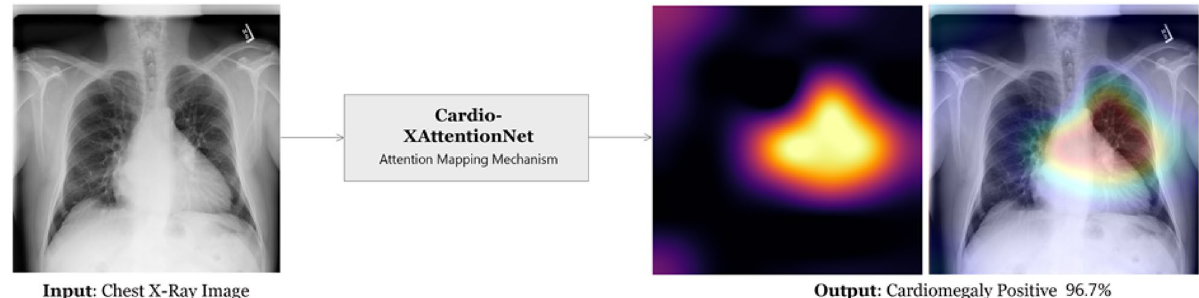
Figure 1. Cardio-XAttentionNet (CXA_Dense121) model, based on DenseNet-121 with Attention Mapping Mechanism, generating accurately positive outcomes with the most indicative region mapping for cardiomegaly, addressing class information and localization on the frontal-view chest X-Ray image. On left side, the original image. On right side, the attention map, and the superimposed outcomes with intensity factor